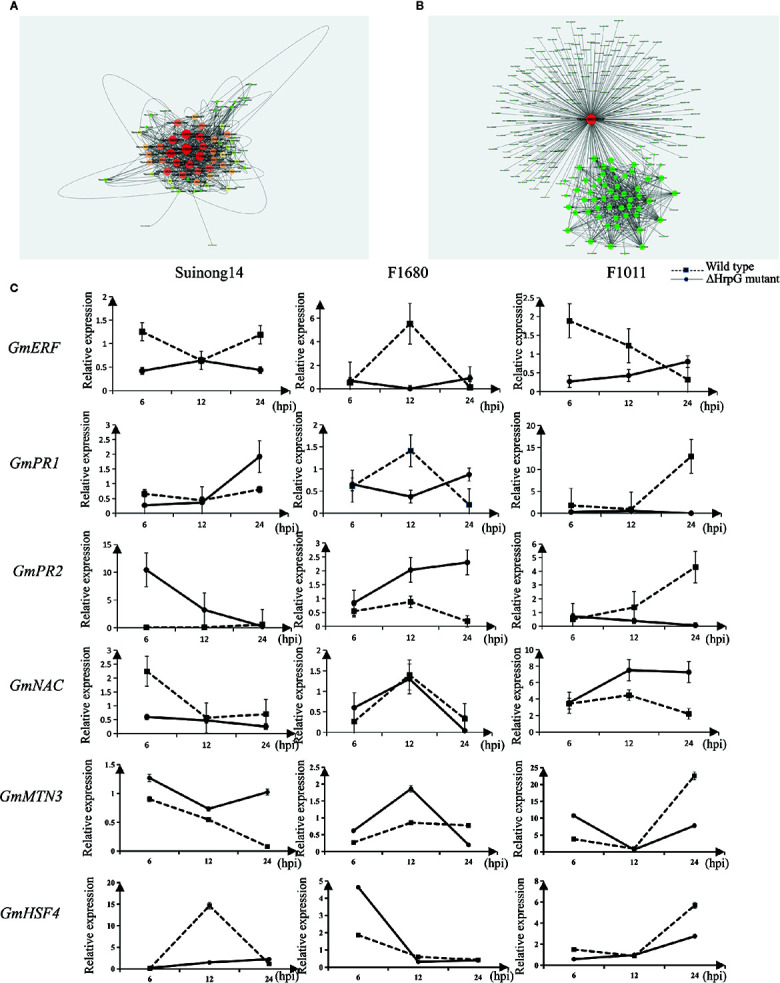
Identification of DEGs on chromosomes 08 and 11. (A, B) Analysis of Glyma.08G00900.1 and Glyma.11G056200.1, which are two hub genes in a gene interaction network. (C) Analysis of candidate gene expression levels in a qRT-PCR assay.